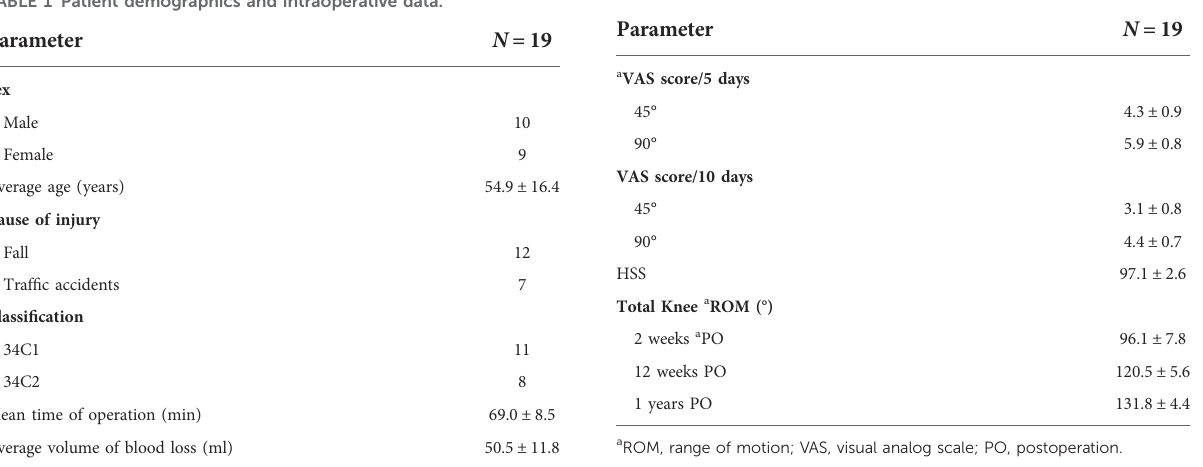
TABLE 2 Postoperative pain and knee function assessment.